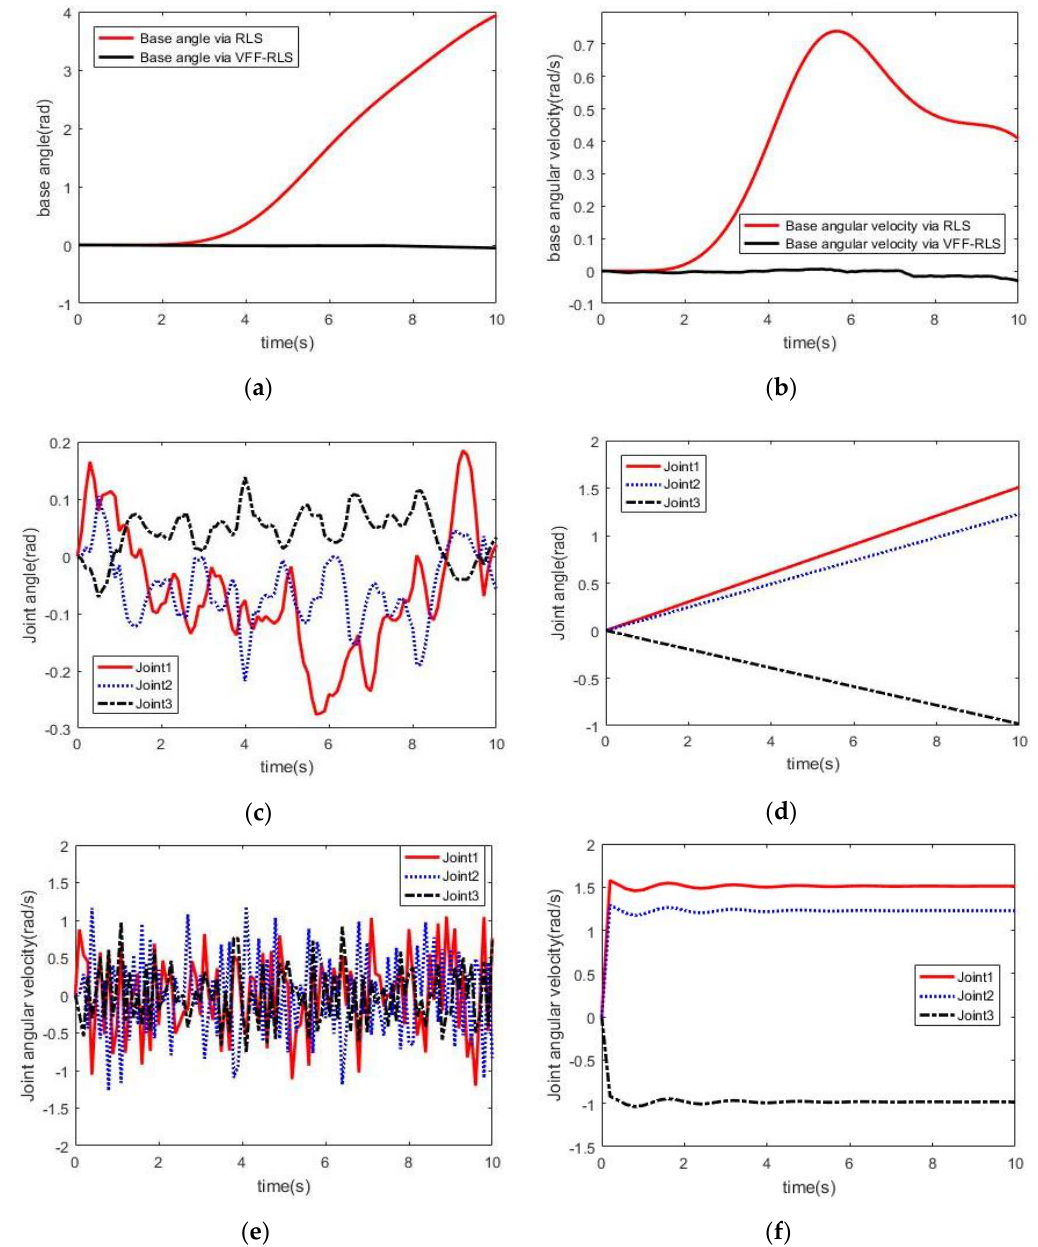
Figure 7. Space robot attitude parameters by simulation. ( a ) The base angle; ( b ) The base angular velocity; ( c ) The joints angle via Variable Forgetting Factor Recursive Least Squares (VFF–RLS); ( d ) The joints angle via RLS; ( e ) The joints angular velocity via VFF–RLS; ( f ) The joints angular velocity via RLS.